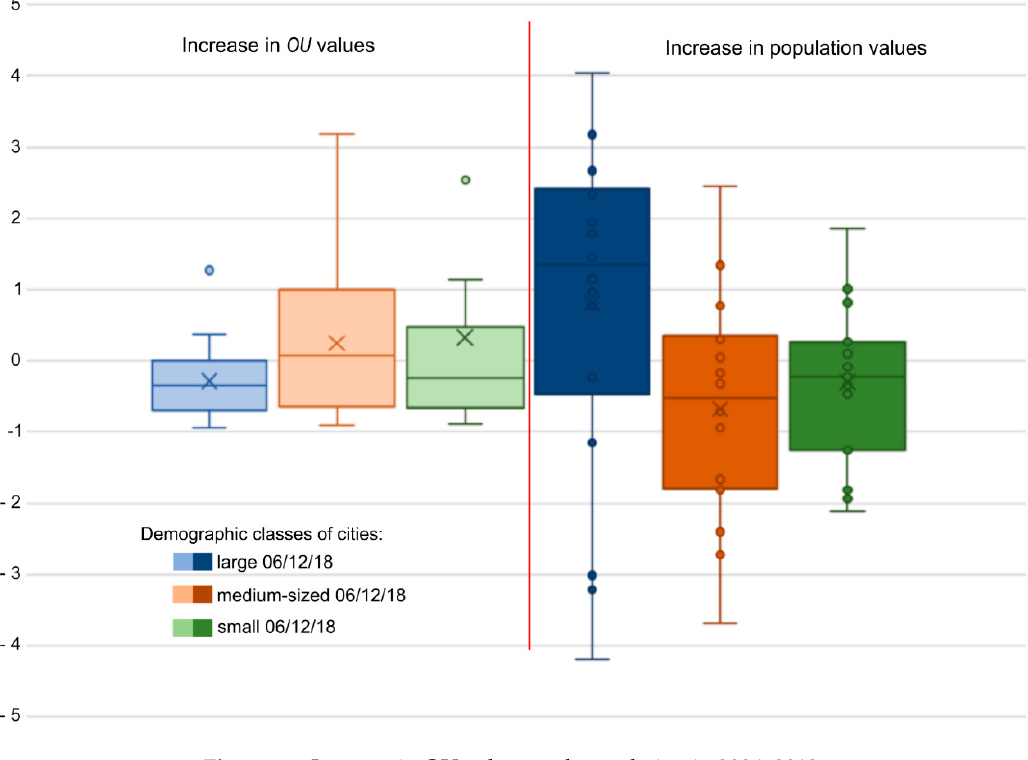
Figure 11. Increase in OU values and population in 2006–2012.